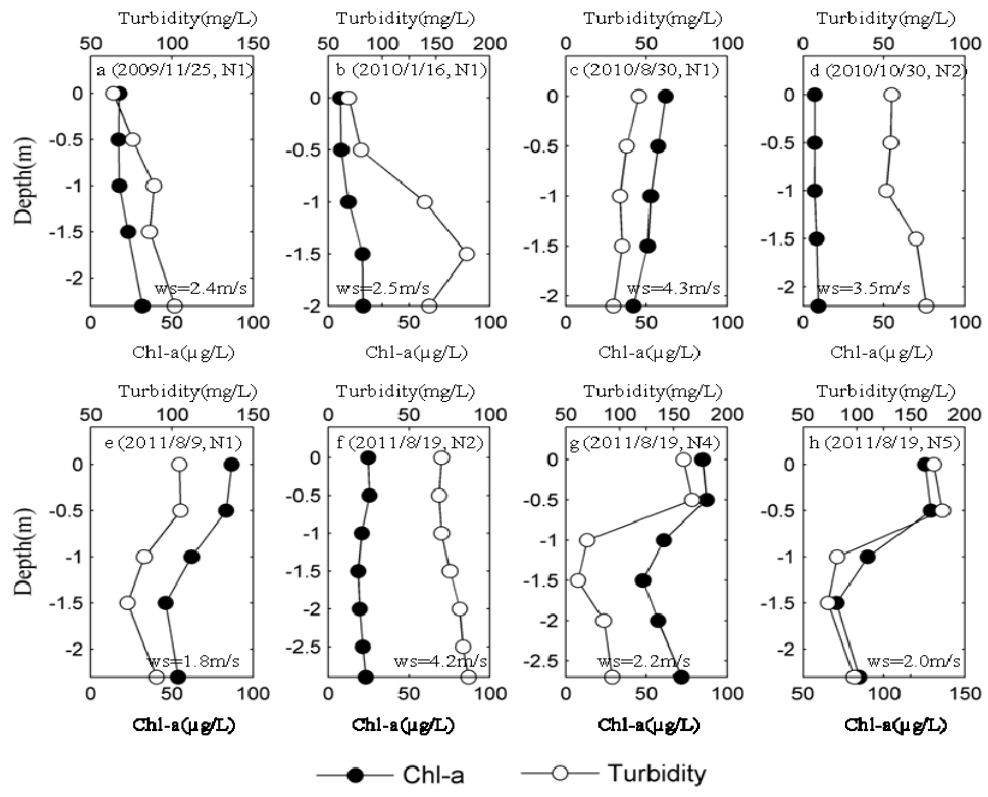
Figure 5. Profiles of turbidity and Chl-a in the lacustrine zone (N1-N5): ( a ) 2009/11/25 at N1; ( b ) 2010/1/16 at N1; ( c ) 2010/8/30 at N1; ( d ) 2010/10/30 at N2; ( e ) 2011/8/9 at N1 ( f ) 2011/8/19 at N2; ( g ) 2011/8/19 at N4; ( h ) 2011/8/19 at N5. “ws” represents the mean wind speed during the study